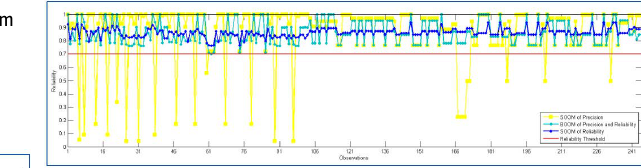
Figure 6: Redundancy number (reliability) of the observations after optimisation procedure. The results of three different optimisation models are compared according to the threshold line.